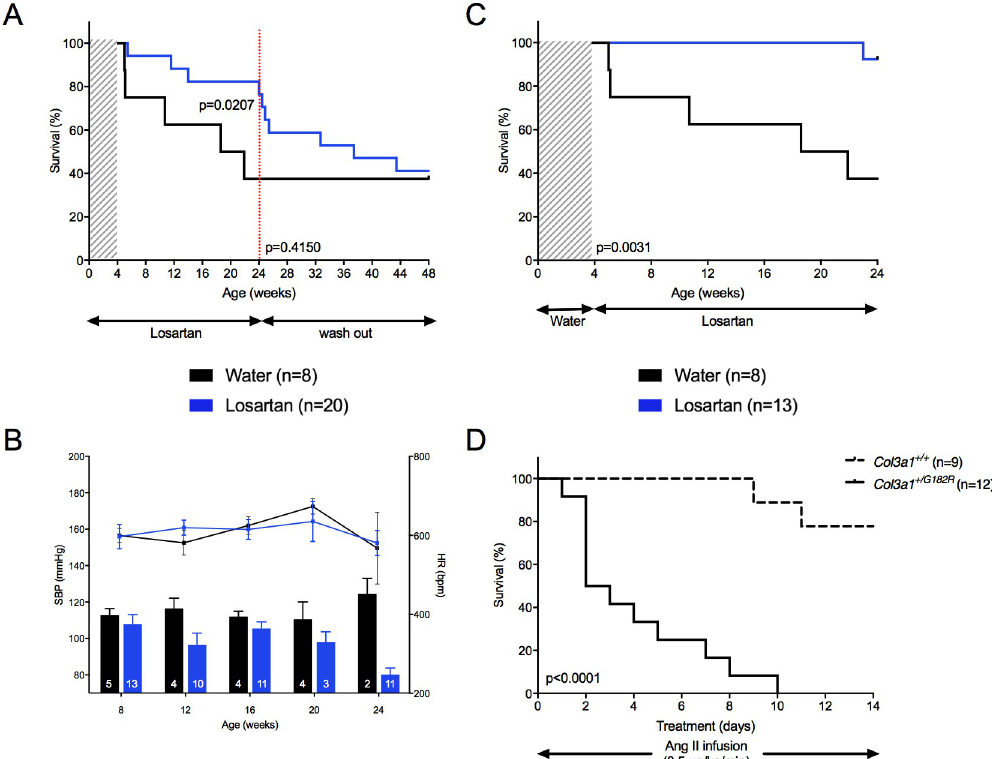
Fig 9. Consequences of on- and off-treatment by losartan. The upper panels represent the survival curves on either active treatment or water. The lower panels represent SBP (lower bars: left scale) and HR (upper lines: right scale), measured between 8 and 24 weeks. Data are expressed as mean ± SEM. Numbers within the bars indicate the number of living mice studied at each time of measurement. A Comparison between losartan started in pregnant mothers and water. Kaplan-Meier Survival curves for comparing Col3a1 +/G182R mice (n = 20) with a 24-week period of losartan followed by a 24-week washout period and Col3a1 +/G182R (n = 8) with no treatment. Significant difference in mortality in treated mice (18% mortality at 24 weeks) compared to the untreated group (63% mortality at 24 weeks) is calculated using Log-Rank (Mantel-Cox) analysis (p = 0.0207) at the end of the 24-week treatment. When the administration of losartan was stopped, an important increased mortality was observed and survival rates at 48 weeks of age were comparable between the 2 groups of mice (41% vs 38%, p = 0.4150). B-C Comparison between losartan started at weaning and water. B SBP was significantly changed by losartan (student t-test, p < 0.05 at 24 weeks of the follow-up period) and HR was not changed by losartan (student t-test, p > 0.05 throughout the follow-up period). C Kaplan-Meier Survival curve for comparing Col3a1 +/G182R treated with Losartan started at age 4 weeks (n = 13) to Col3a1 +/G182R treated with water (n = 8). Losartan significantly improve the survival using Log- Rank (Mantel-Cox) analysis (p = 0.0031). D Kaplan-Meier Survival curve for comparing Col3a1 +/+ (n = 9, doted curve) to Col3a1 +/G182R (n = solid curve) male mice with Angiotensin II infusion (0.5 μ g/kg/min). Significant difference is calculated using Log-Rank (Mantel-Cox) analysis (p <